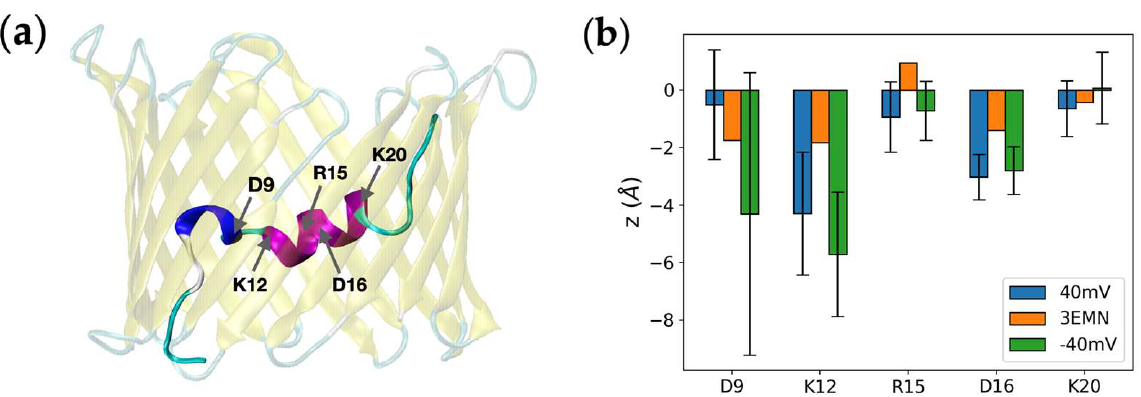
Figure 3. ( a ) Crystal structure of VDAC1 showing charged residues involved in the N-terminus. ( b ) Average position along z of the C α atom of each charged residue obtained from aMD simulations at +40 mV and −40 mV. 𝑧 = 0 Å roughly corresponds to the middle of the pore. Error bars corresponding to standard deviations were also added.